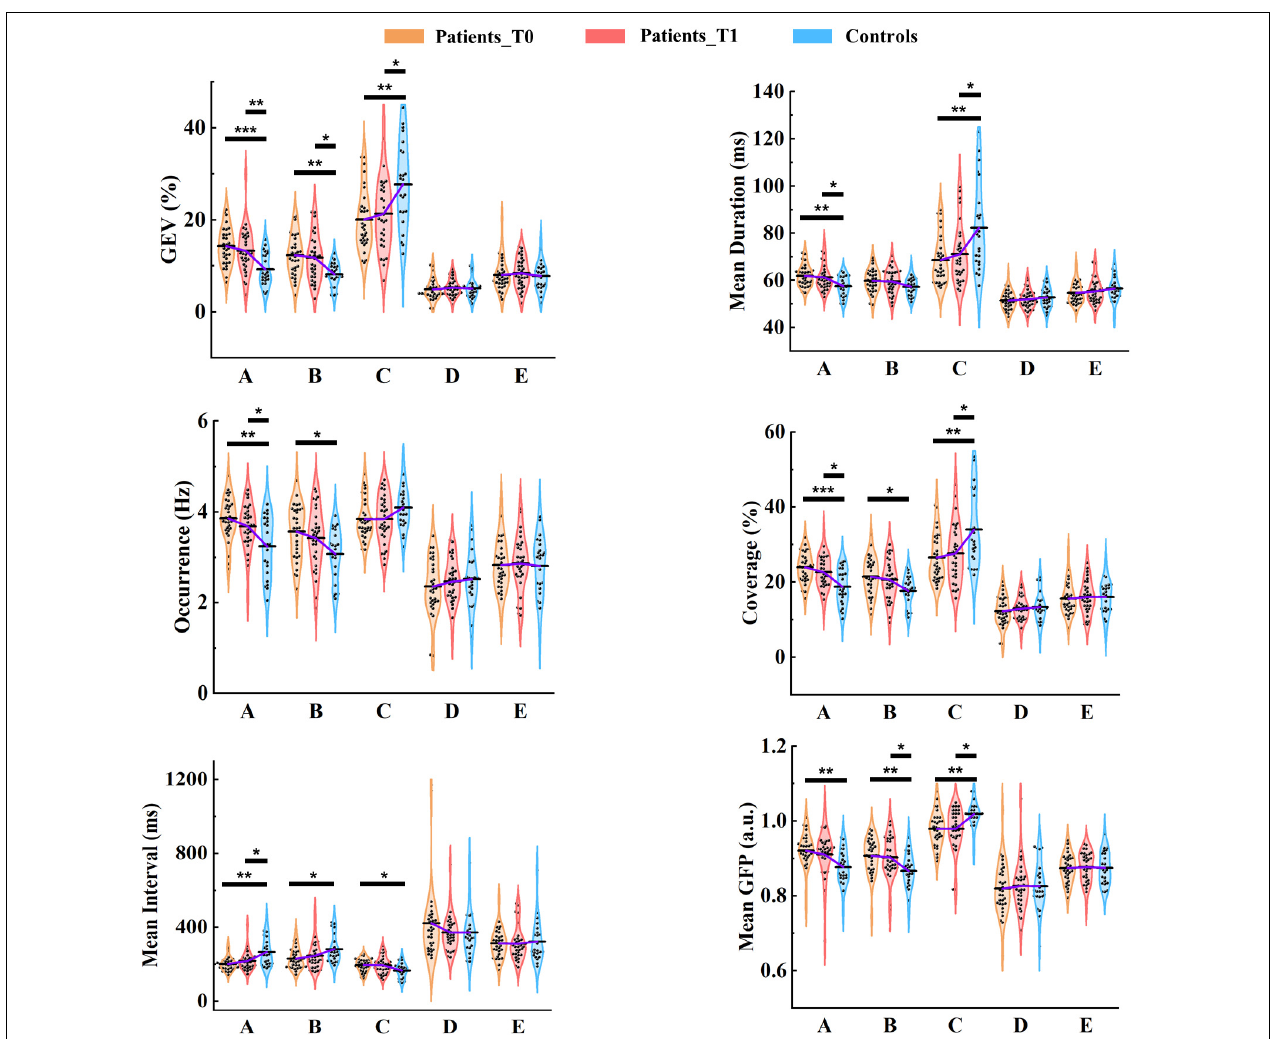
FIGURE 5 | Results of microstate parameter analysis for patients and controls. Post hoc pairwise comparisons (patients at T0 vs. controls; patients at T1 vs. controls) were performed for GEV, mean duration, occurrence, coverage, mean interval, and mean GFP. The means of the three groups for each microstate class are linked by the solid purple line. * p < 0.05; ** p < 0.01; *** p <